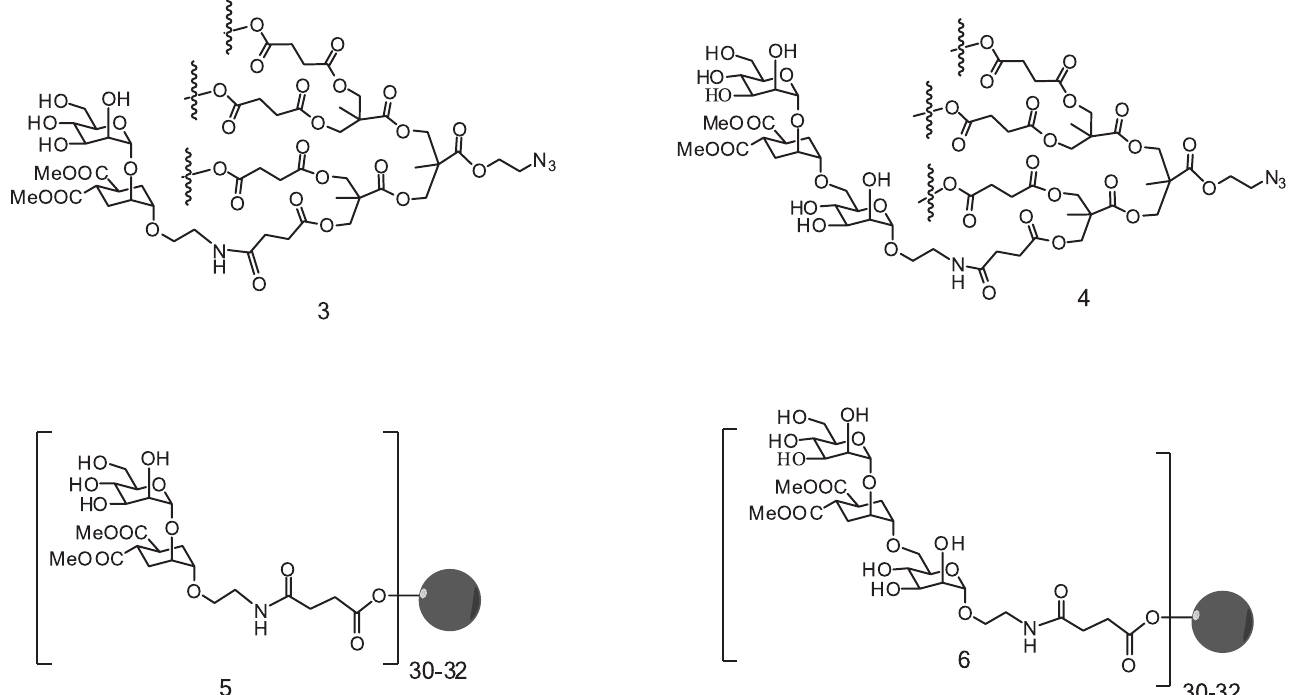
FIGURE 7 - Structure of tetravalent glycodendrons 3 and 4 and glycodendrimers 5 and 6